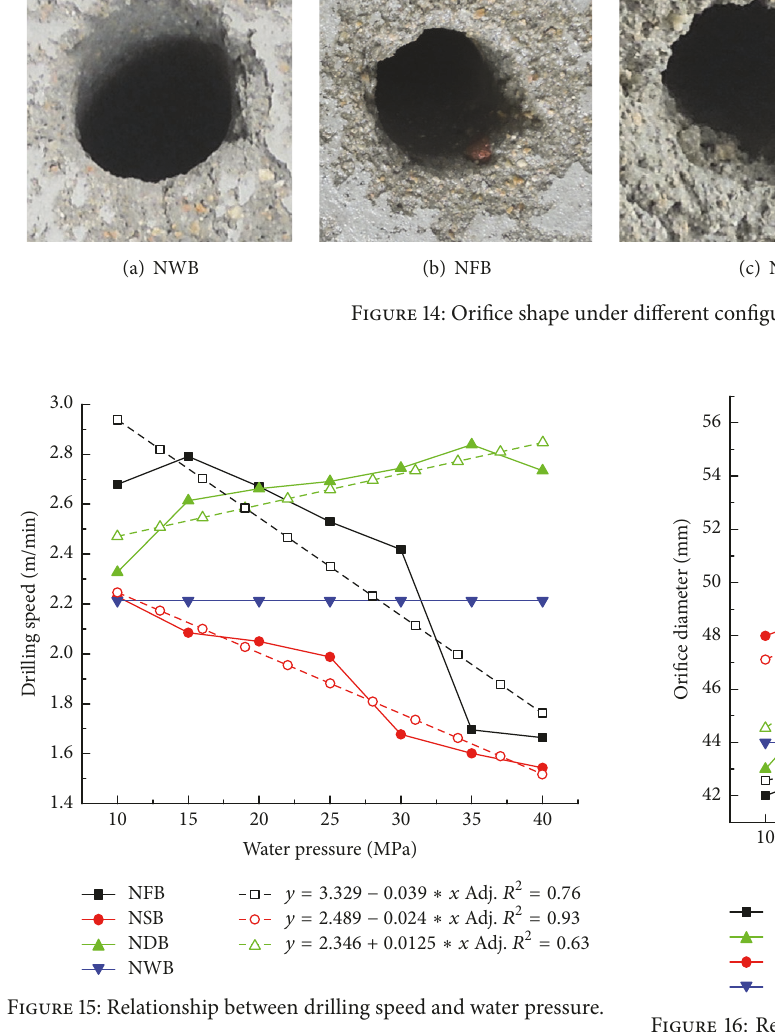
Figure 16: Relationship between orifice diameter and water pres-